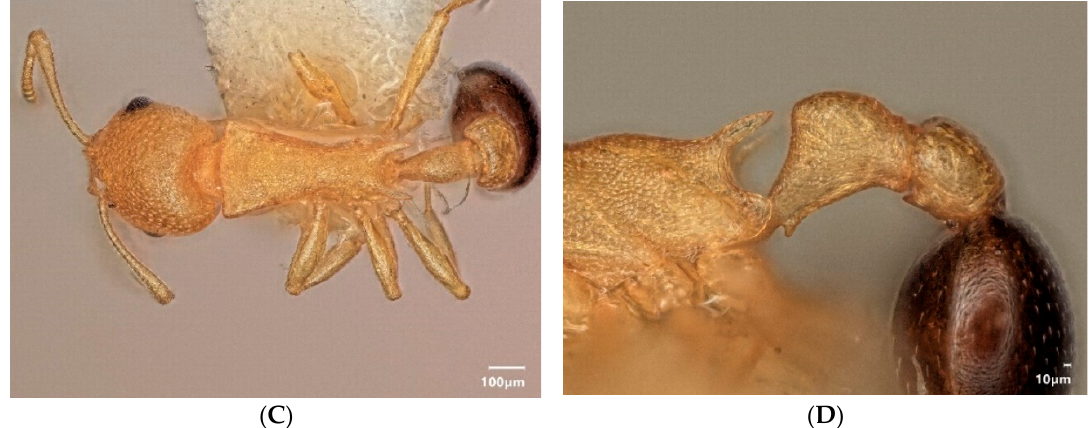
Figure 24. Cardiocondyla subspina n.sp., paratype: head in dorsal view ( A ), lateral view ( B ), dorsal view ( C ), waist in lateral view ( D ).